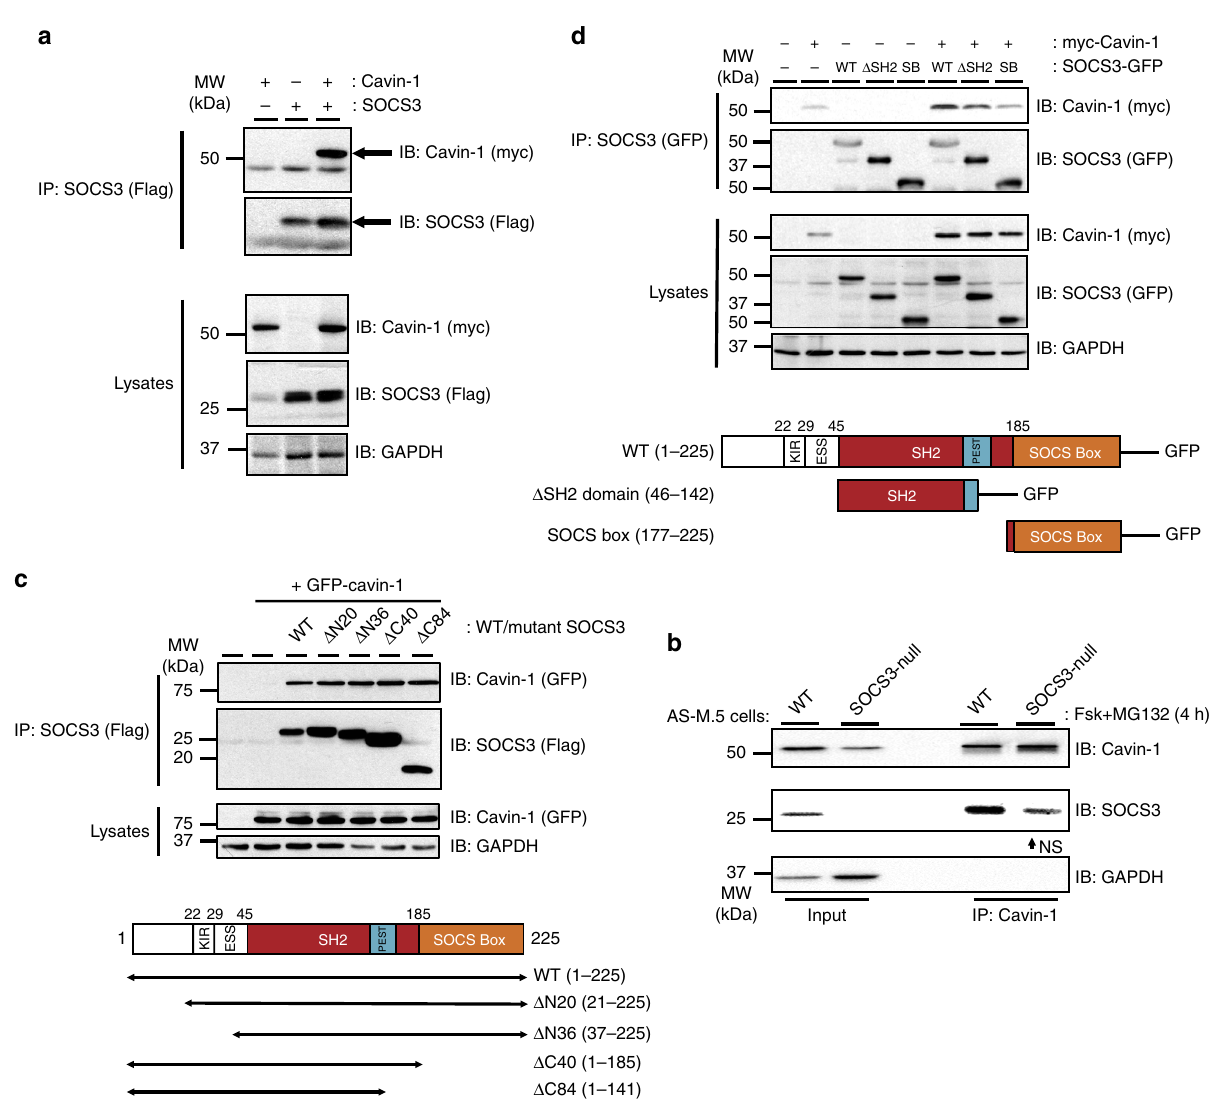
Fig. 3 A region within the SOCS3 SH2 domain is necessary and suf fi cient for cavin-1 interaction. a Protein-equalised soluble cell extracts from HEK293 cells transfected with expression constructs encoding Flag-SOCS3 and myc-tagged cavin-1 as indicated were processed by immunoprecipitation (IP) with anti- Flag M2-agarose beads prior to SDS-PAGE and immunoblotting with the indicated antibodies. Whole-cell lysates from the samples used in the IP were also fractionated by SDS-PAGE for immunoblotting in parallel. b Protein-equalised soluble cell extracts from WT and SOCS3-null AS-M.5 cells treated with 50 μ M Fsk and 6 μ M MG132 for 4 h were processed by IP with anti-cavin-1 antibody prior to SDS-PAGE and immunoblotting with the indicated antibodies. As loss of SOCS3 in AS-M.5 cells reduces cavin-1 protein levels ( a ), twice the amount of protein was used as input for SOCS3-null cells to compensate. NS = non-speci fi c band. c Upper: Protein-equalised soluble cell extracts from HEK293 cells transfected with expression constructs encoding either Flag-tagged WT SOCS3 or the indicated truncation mutants and GFP-tagged cavin-1 as indicated were processed by IP with anti-Flag M2-agarose beads prior to SDS- PAGE and immunoblotting with the indicated antibodies. Whole-cell lysates from the same samples used in the IP were also fractionated by SDS-PAGE for immunoblotting in parallel. Lower: Schematic of the SOCS3 truncation constructs used, KIR = kinase inhibitory region, ESS = extended SH2 subdomain, PEST = PEST (ProGluSerThr) motif. d Upper: Protein-equalised soluble cell extracts from HEK293 cells co-transfected with expression constructs encoding either full-length SOCS3 (WT), a truncated Δ SH2 SOCS3domain ( Δ SH2), or SOCS box domain (SB) fused to GFP and myc-tagged cavin-1 as indicated were processed by IP with anti-GFP antibody and protein G-Sepharose beads prior to SDS-PAGE and immunoblotting with the indicated antibodies. Whole- cell lysates from the same samples used in the IP were also fractionated by SDS-PAGE and for immunoblotting in parallel. Lower: Schematic of the SOCS3- GFP fusions